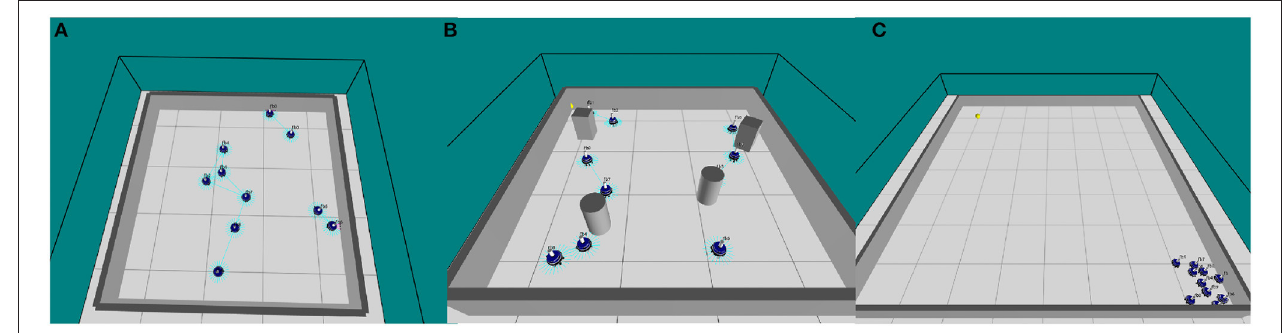
FIGURE 1 | (A) ARGoS simulation of 10 marXbot robots performing obstacle avoidance in an empty arena (O’Keeffe et al., 2017a), (B) ARGoS simulation of 10 marXbot robots performing obstacle avoidance in a cluttered arena, and (C) ARGoS simulation of 10 marXbot robots performing collective photo-taxis in an arena with a beacon in the north-west corner.